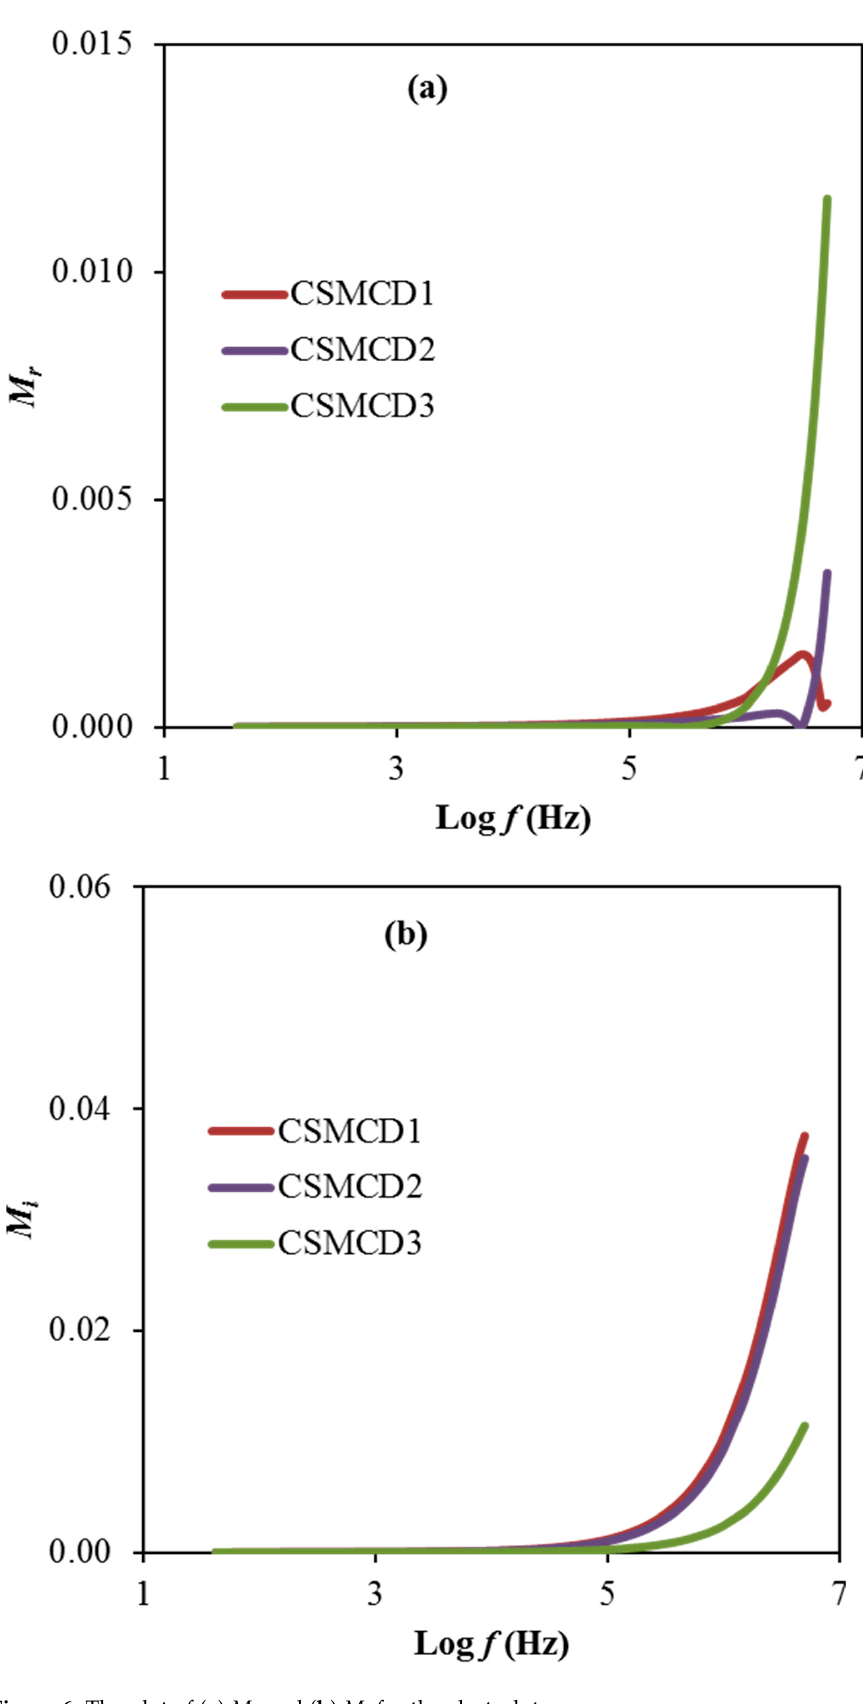
Figure 6. The plot of ( a ) M r and ( b ) M i for the electrolytes.